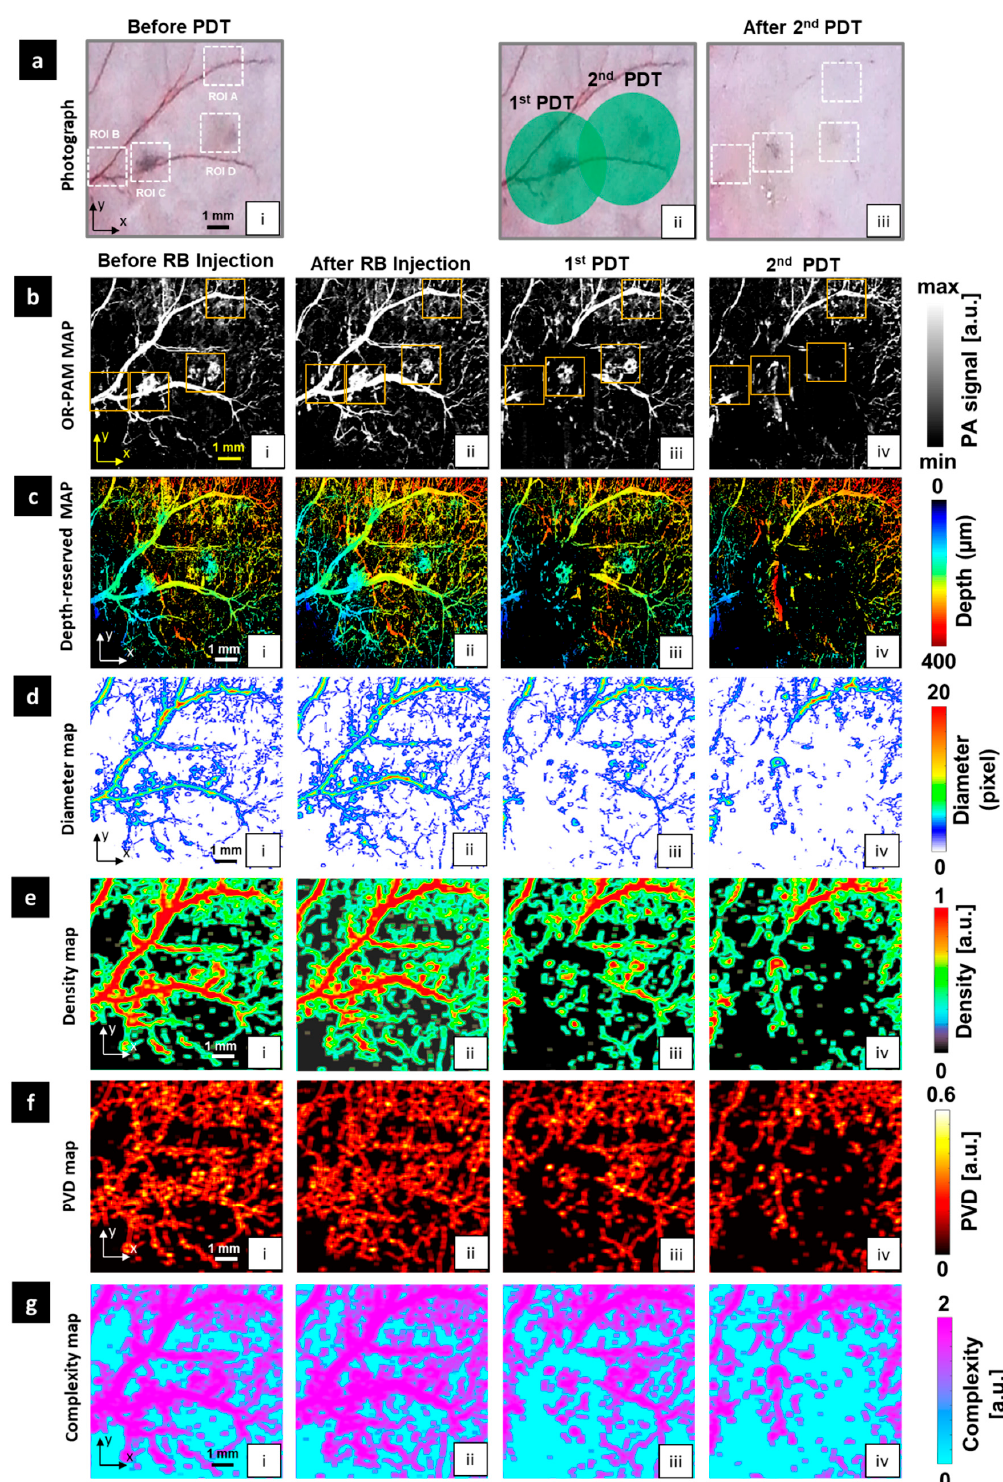
Figure 4. In vivo OR-PAM monitoring of melanoma tumors and micro-vessels in the mouse ear before and after two PDT applications. ( a ) Photographs of mouse ear; a(i) before PDT, a(ii) after PDT beam irradiation, a(iii) after two PDT treatments. ( b ) OR-PAM MAP images. ( c ) Depth-resolved OR-PAM MAP images. ( d ) Diameter map. ( e ) Density map. ( f ) PVD map. ( g ) Complexity map. For all images for ( b – g ): (i) Before rose bengal (RB) injection, (ii) after RB injection, (iii) after 1st PDT, and (iv) after 2nd PDT.